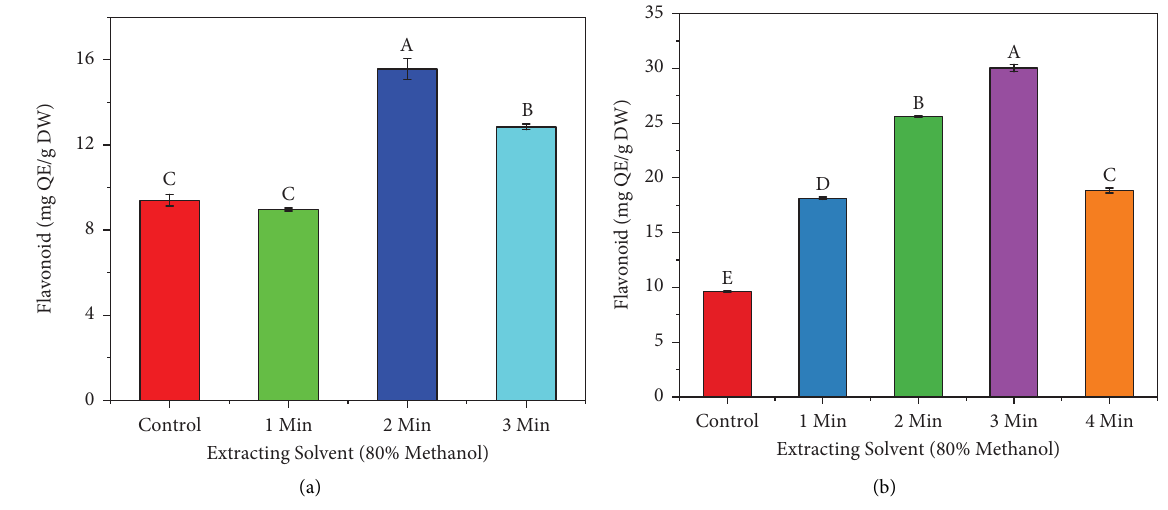
Figure 20: Estimation of favonoid contents in untreated and plasma treated seeds of (a) radish and (b) carrot.